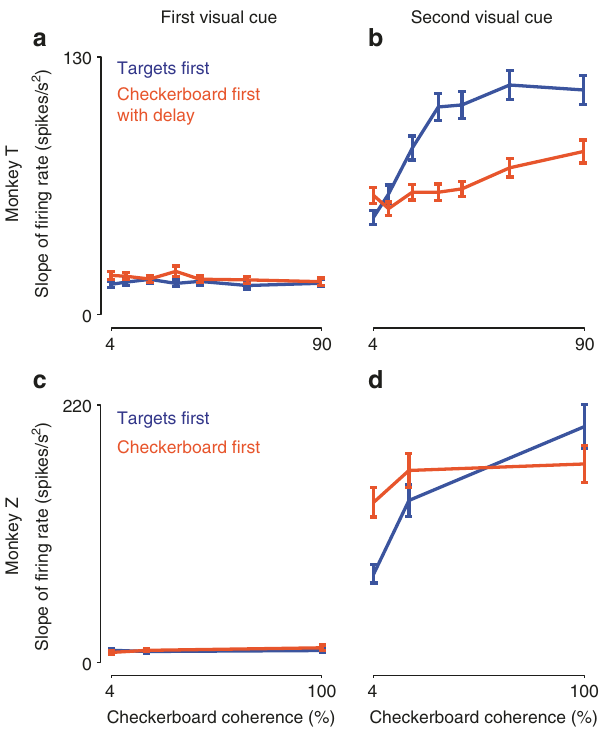
Fig. 4 Neural activity re fl ected action choice and unsigned checkerboard coherence following the second visual cue. Plotted are the discharge rate slopes (mean ± s.e.m.) of the choice selectivity signal as a function of checkerboard coherence. The choice selectivity signal is the difference in activity for the two opposite reach directions. For each unit, the choice selectivity signal recorded 0 – 300 ms after the appearance of the fi rst visual cue ( a , c ) and the second visual cue ( b , d ) was calculated separately for trials with each checkerboard coherence in the TF (blue) and CFD/CF tasks (orange), and then fi t to a linear ramp function to estimate the short- latency rate of change of activity in response to the two visual cues (see Methods). While observing the fi rst visual cue, choice selectivity signal slopes were small and did not vary as a function of checkerboard coherences in both tasks in T ( a ) and Z ( c ), even while observing the checkerboards in the CFD/CF task. This indicated that the fi rst cue did not evoke a predictive directional signal in neural activity, as should be expected. Following the appearance of the second visual cue in each task however, strong choice selectivity signals appeared in PMd in both T ( b ) and Z ( d ). Slopes of the signals were strongly modulated by checkerboard coherence in the TF task (blue) but much less sensitive to checkerboard coherence in the CFD/CF task (orange) in both monkeys. This would be expected if the sensory evidence about the dominant color of the checkerboard had been processed before the colored targets appeared in the CFD/CF tasks and then stored in a form that was more amenable for a binary decision about action